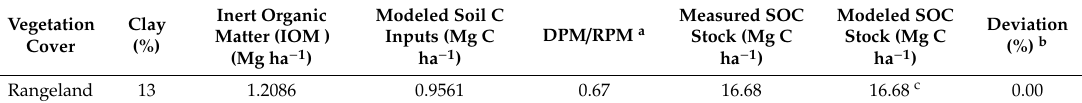
Table 2. Input data, measured and modeled SOC stock in 2002 (mean values of the samplings in January 2002) in the native